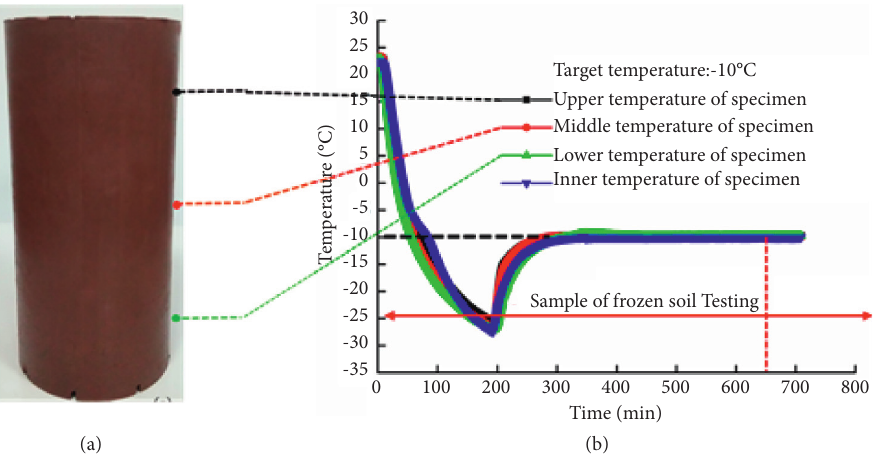
Figure 3: Formation process of frozen soil samples: (a) hollow cylindrical specimen; (b) the temperature change process of hollow cylindrical